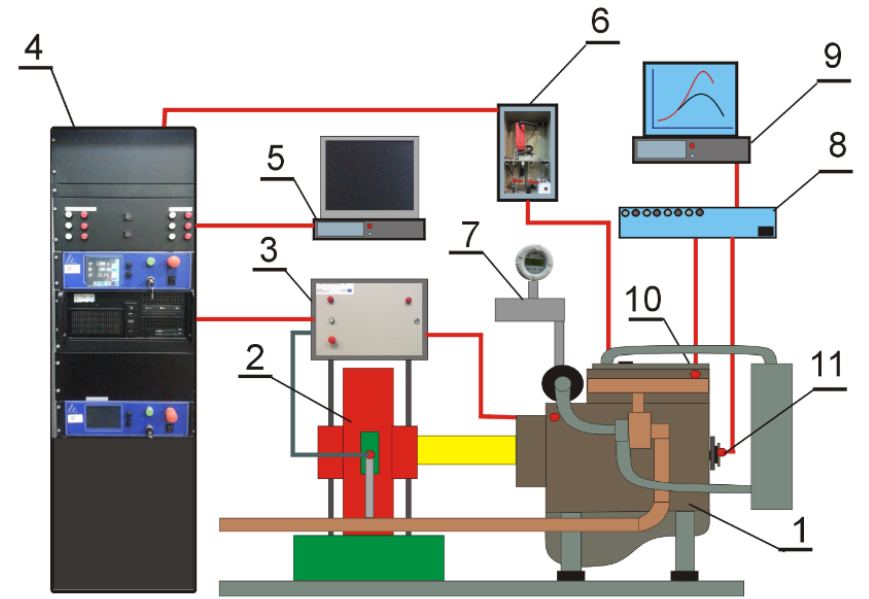
Figure 2. Set-up of the test stand: 1—Perkins 1104D-44TA engine, 2—Automex AMX-200/6000 brake, 3—measurement module, 4—measurement cabinet with the control system, 5—computer used to control the stand parameters and to archive test results, 6—fuel mass dosing device, 7—air flow meter, 8—AVL Indicom 612 system, 9—computer used to control the measurements, 10—engine cylinder pressure sensor, 11—engine crank angle encoder.